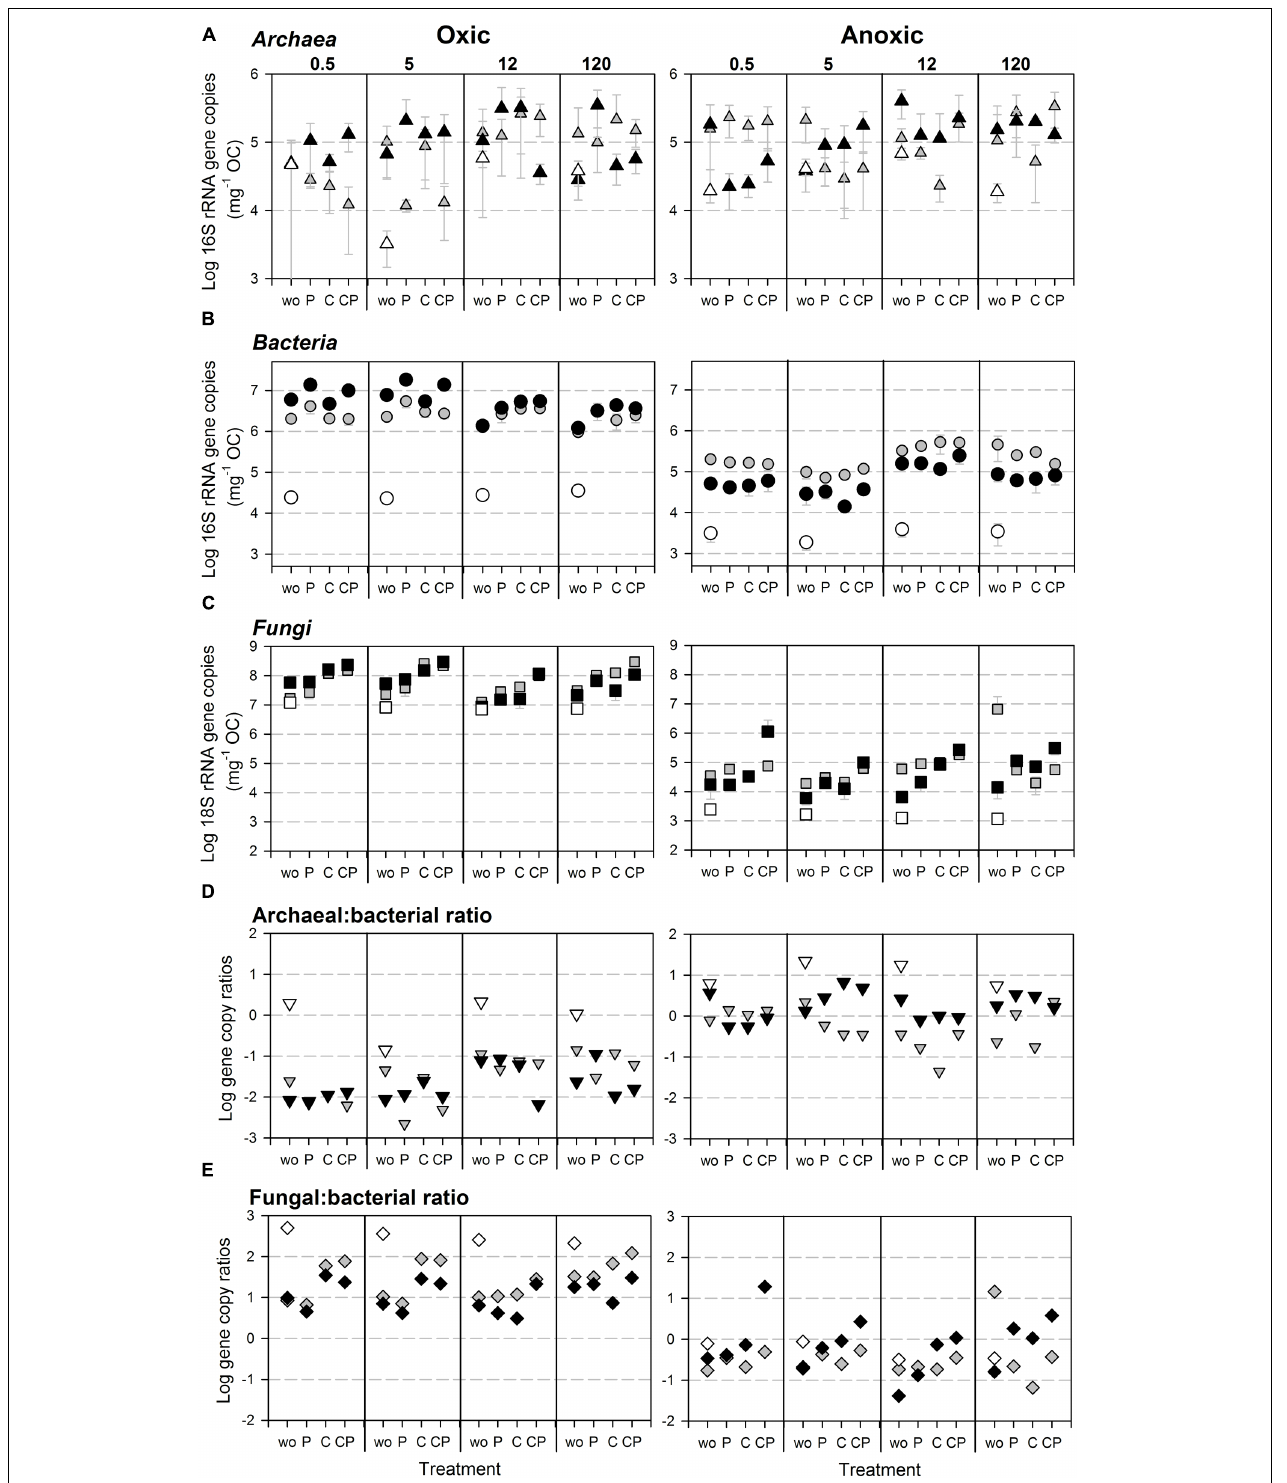
FIGURE 4 | Abundances of SSU rRNA gene copies normalized to initial OC content in the soil microcosm incubation experiment for (A) Archaea , (B) Bacteria (assay Gray et al., 2011), and (C) Fungi as well as (D) archaeal to bacterial, and (E) fungal to bacterial SSU rRNA gene copy ratios under oxic (Left) and anoxic (Right) conditions. Gray shades of symbols indicate soil fraction: bulk (gray), HF (black), and LF (white, only wo-treatment). Every plot shows gene copy numbers of the differently aged soils (0.5, 5, 12, and 120 kyr), each with the four treatments (wo, P, C, and CP). Error bars indicate standard deviation of three parallel incubation